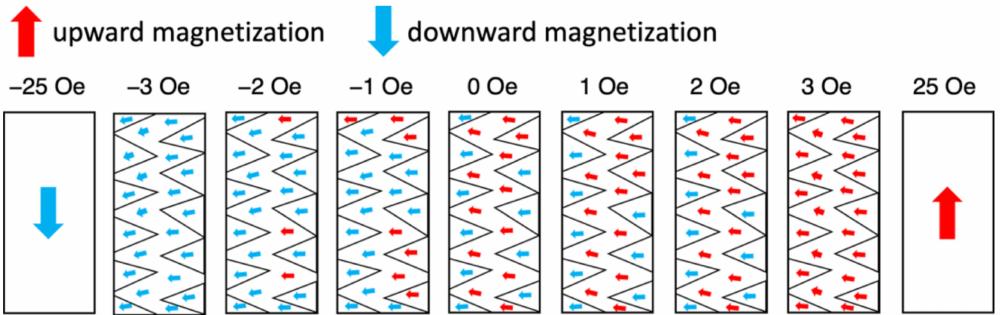
Figure 7. Magnetization directions calculated from the brightness values for the section of wire shown in Figure 5a.